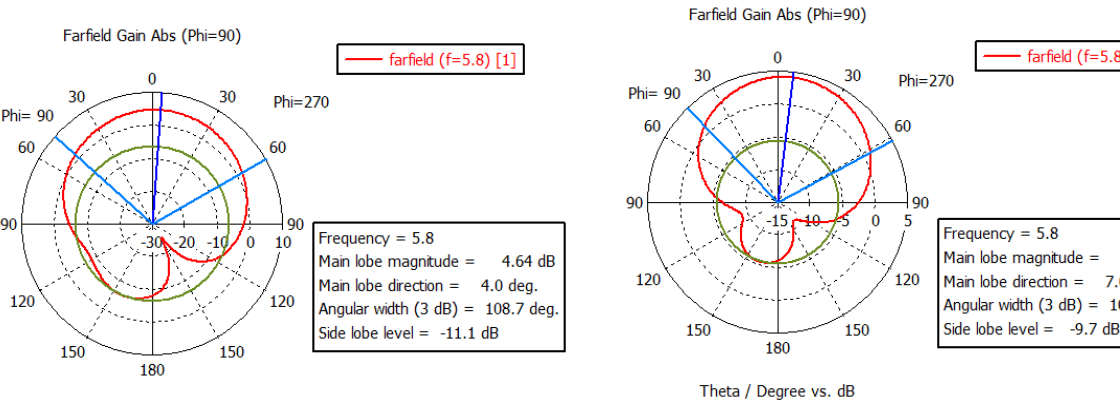
Figure 16. Far field region for Bakelite.